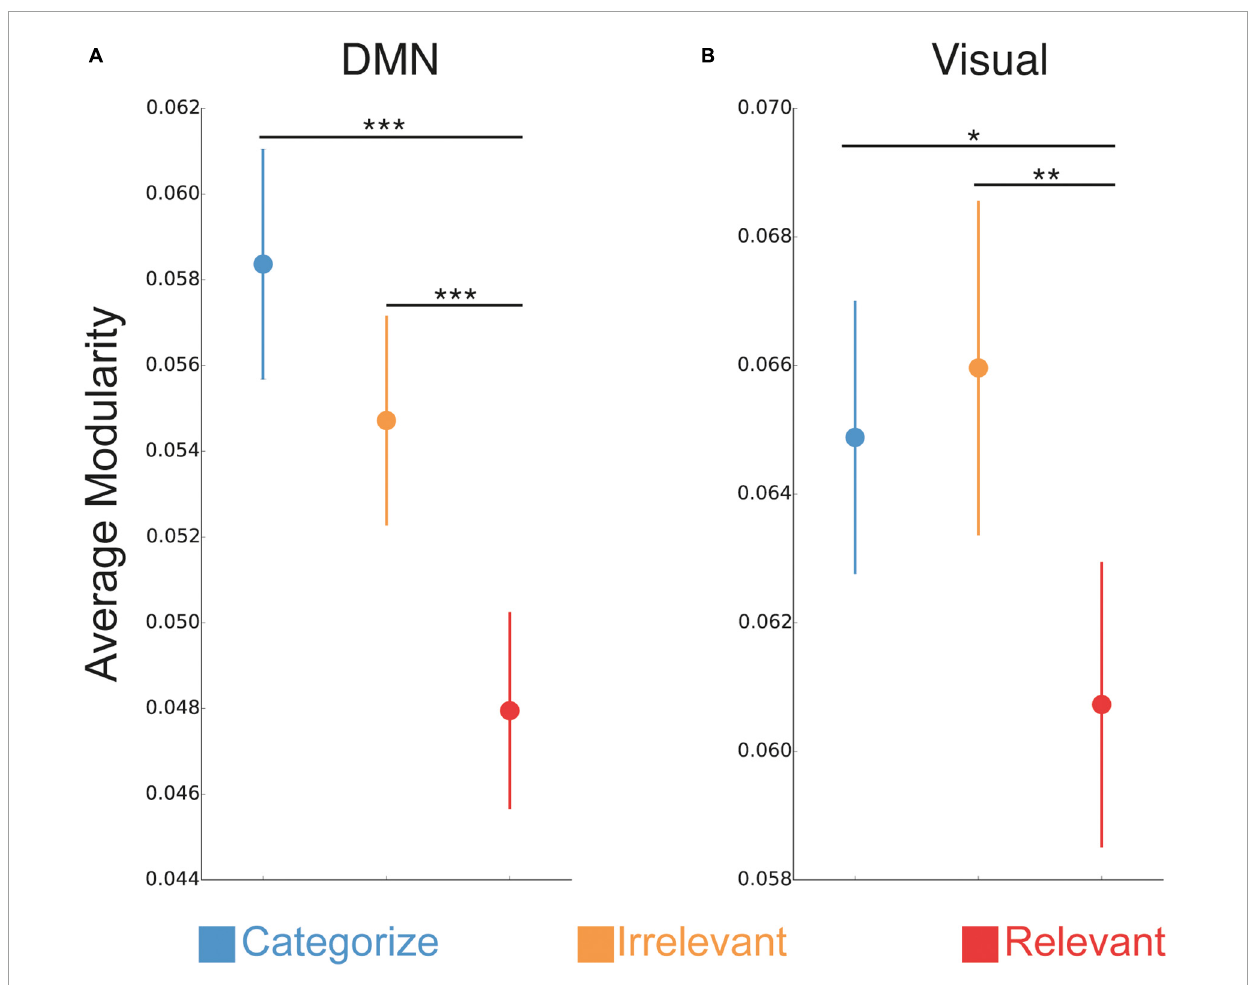
FIGURE4 Sub-network changes in modular network organization. Changes in network modularity between trials with relevant stimuli compared categorized and irrelevant stimuli (average of faces and scenes) for DMN (A) and visual sub-networks (B) . ***P < 0.001; **P < 0.01; *P < 0.05.